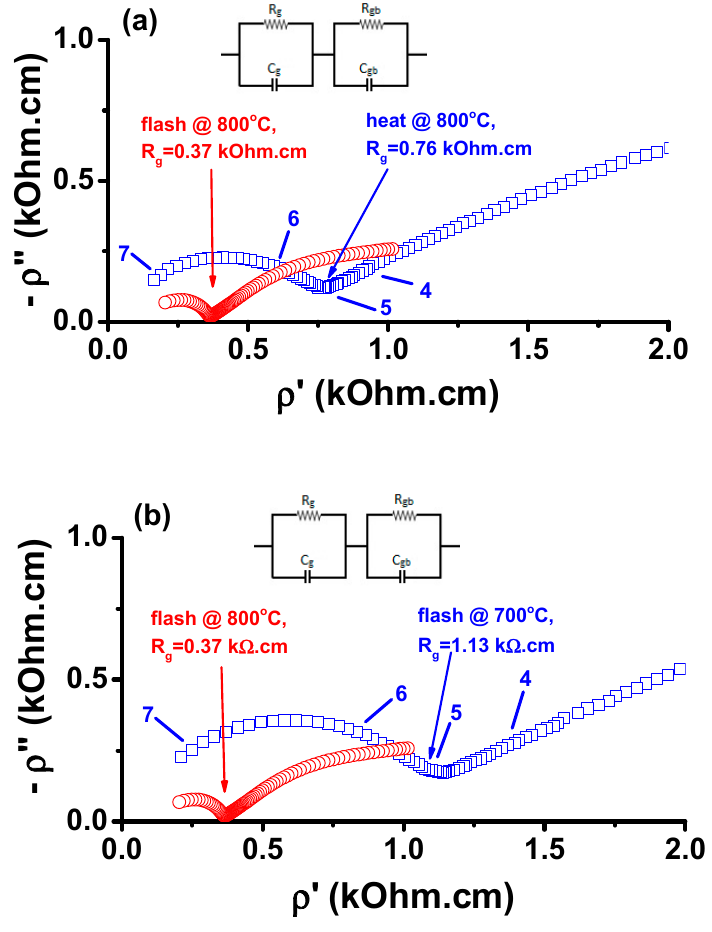
Figure 4. Impedance spectroscopy plots of BITIVOX ceramic pellets and equivalent circuits: ( a ) sintered at 800 ◦ C / 5 min and flash sintered applying 200 V cm − 1 at 800 ◦ C for 5 min; ( b ) flash sintered applying 200 V cm − 1 at 700 ◦ C / 5 min and at 800 ◦ C / 5 min; Temperature of measurement: 400 ◦ C. Numbers stand for log f (f: Hz).